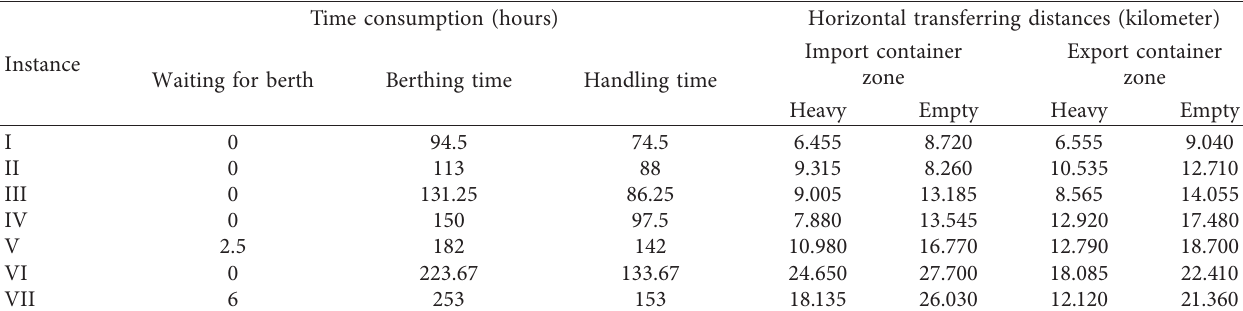
Table 9: The components of objective function values for BYIS-SDTT and